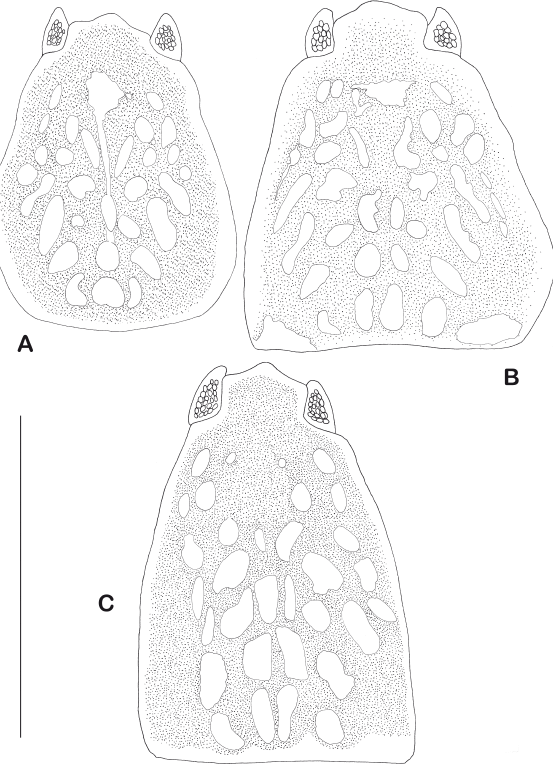
Fig. 4. – Pigmentation of carapace. A, Zeuxo sp. A (Korea). B, Zeuxo sp. B (Turkey). C, Zeuxo holdichi (Spain). Scale bar, 0.5 mm.